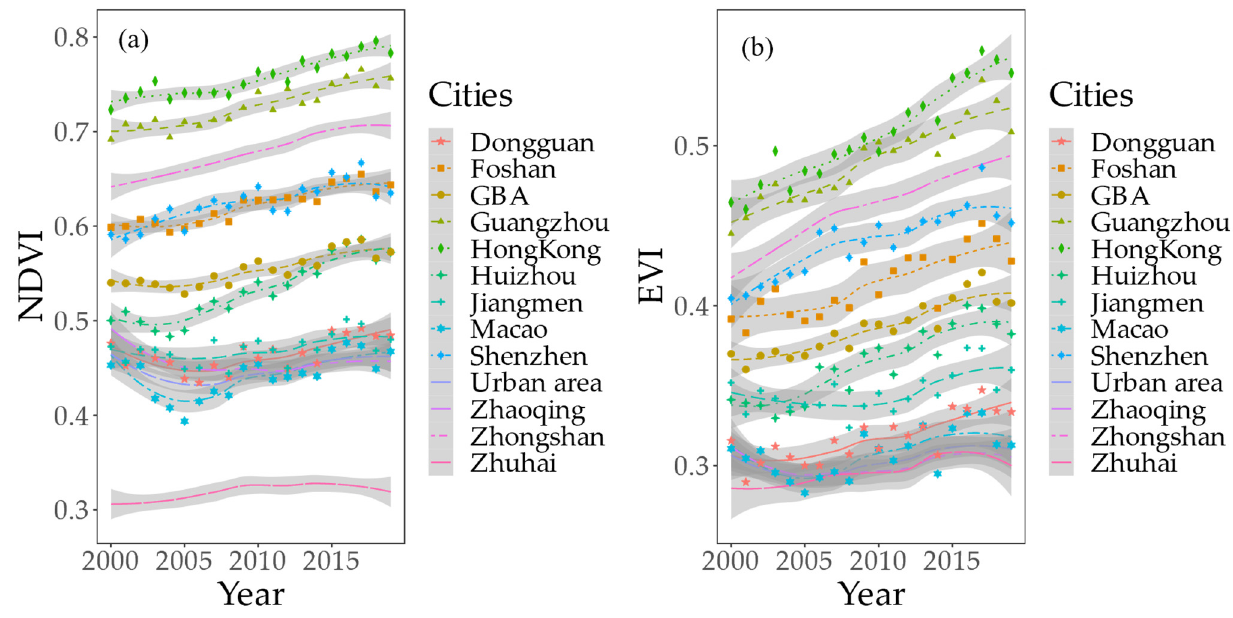
Figure 5. Overall change trend for vegetation from 2000 to 2019. ( a ) NDVI change trend ( b ) EVI change trend.